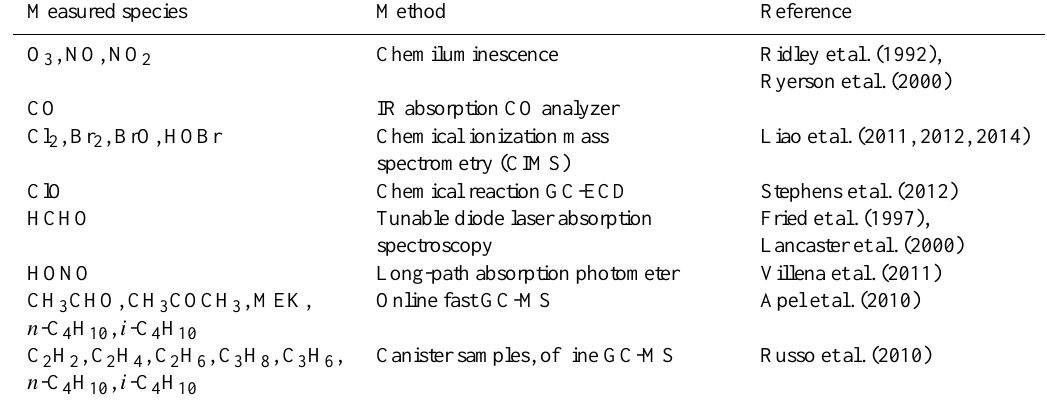
Table 5. Summary of the ambient measurements from OASIS that were used to constrain the model and the instrumental method